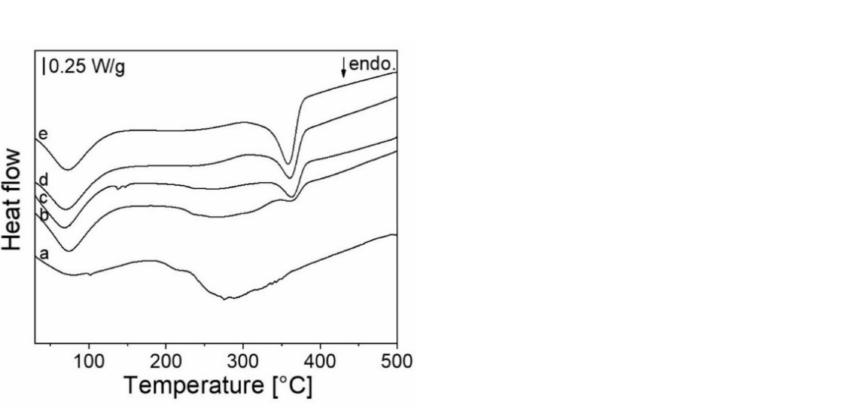
Figure 7. DSC curves of samples at 150 ◦ C: ( a ) 100% hydrolyzed wool; ( b ) 50%-50% kraft pulp/ hydrolyzed wool; ( c ) 70%-30% kraft pulp/hydrolyzed wool; ( d ) 90%-10% kraft pulp/hydrolyzed; and finally ( e ) 100% kraft cellulose.